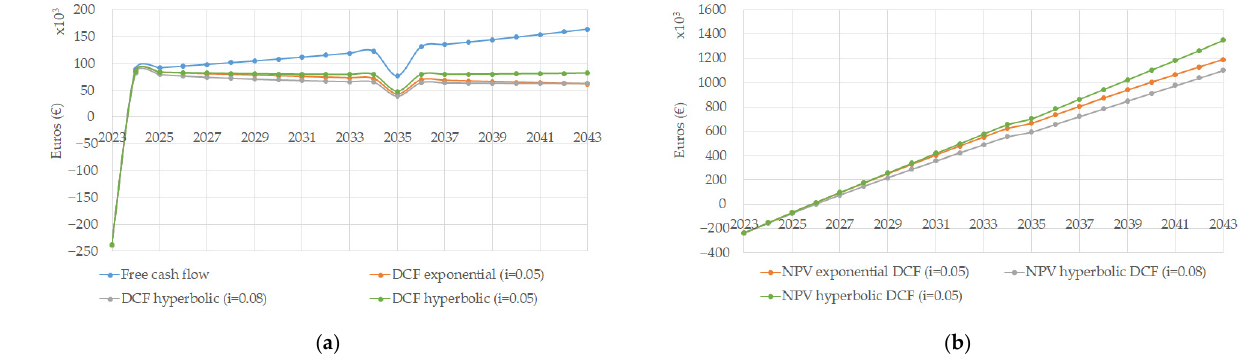
Figure 19. CBA results; ( a ) free cash flows and discounted cash flows (DCF): traditional exponential discounting with i E = 0.05, hyperbolic discounting with i H = 0.08, and hyperbolic discounting with i H = 0.05; ( b ) cumulative NPV for the different discounting approaches.